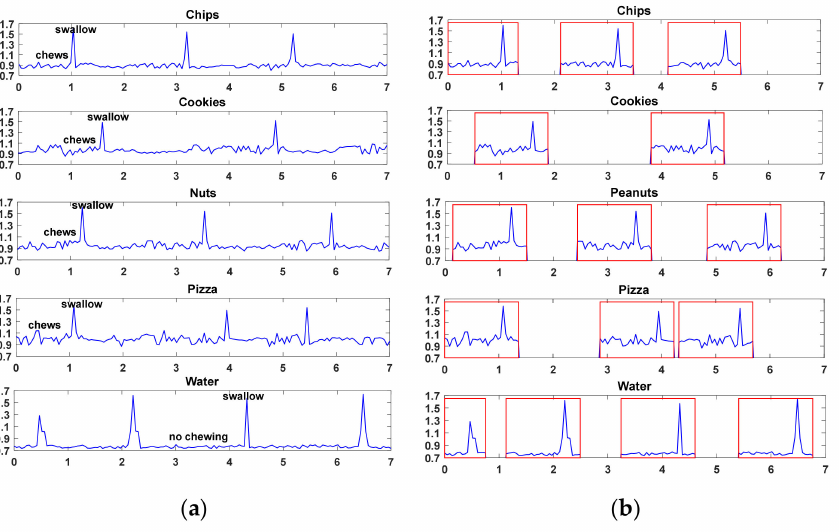
Figure 4. Food ingestion pattern waveform: ( a ) The eating pattern of all the ingested food categories; ( b ) Extracted frames from the ingestion pattern of foods are enclosed by